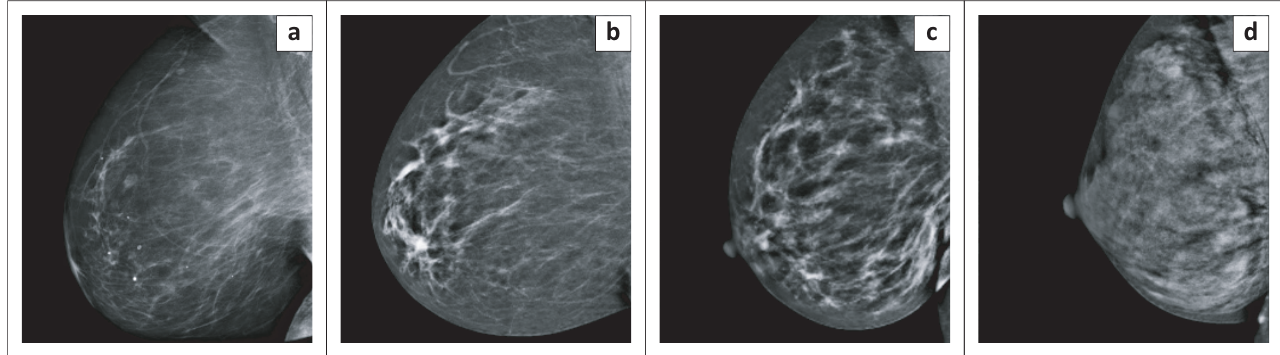
Kaur SD. How to decrease breast density to reduce breast cancer risk 2016. [homepage on the Internet]. c2016 [cited 2018 Apr 7]. Available from: http://mammalive.net/resources/decrease- breast-density-reduce-breast-cancer-risk/ FIGURE 1: Mammographic demonstration of Breast Imaging Reporting and Data System (BI-RADS) breast density categories: (a) < 25% density – fatty breast tissue; (b) < 50% density – scattered density; (c) > 50% density – heterogeneously dense; and (d) > 75% density – extremely